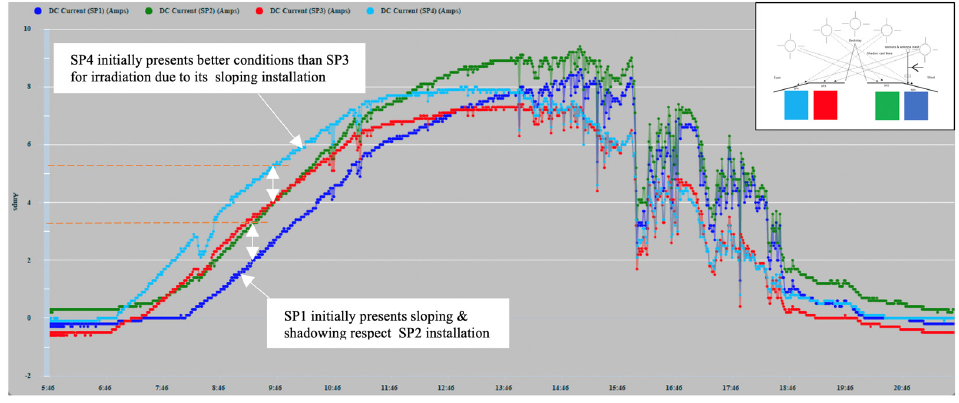
Figure 12. 16 May 2021 zoom.